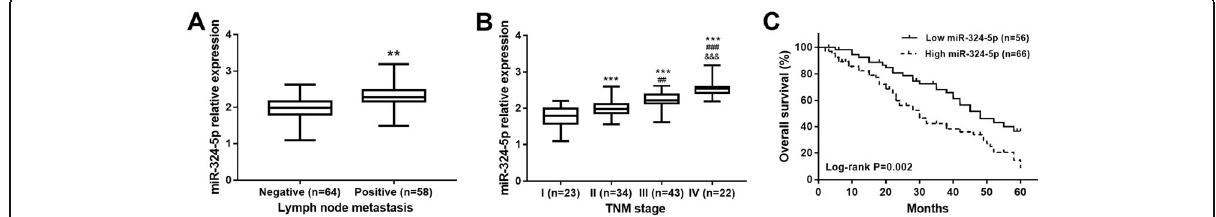
Fig. 2 Association of miR-324-5p with lymph node metastasis, TNM stage and overall survival in patients with GCa. a . GCa patients with positive lymph node metastasis had significant high miR-324-5p expression (** P <0.01). b . miR-324-5p expression was elevated with the increase of TNM stage, and the highest miR-324-5p expression was observed in patients with TNM stage IV (*** P <0.001 compared to stage I, ## P <0.01, ### P <0.001 compared to stage II, &&& P <0.001 compared to stage III). c . Survival curves for GCa patients based on Kaplan-Meier method (log-rank P = 0.002)